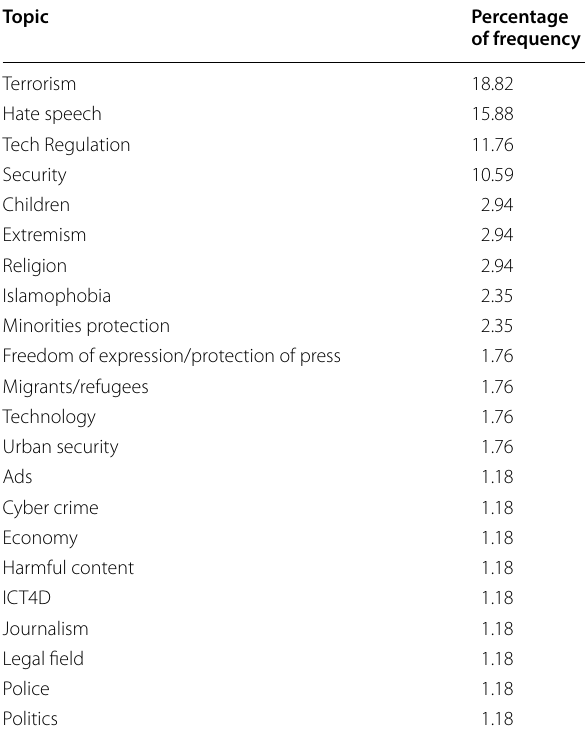
Table 8 Online controversy categorisation of topics (manual categorisation, one topic assigned to each